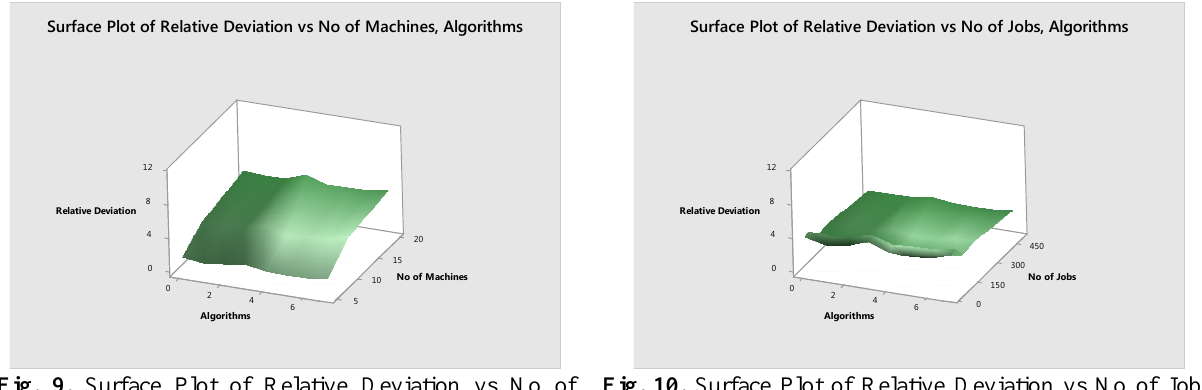
Fig. 9. Surface Plot of Relative Deviation vs No of Machines, Algorithms